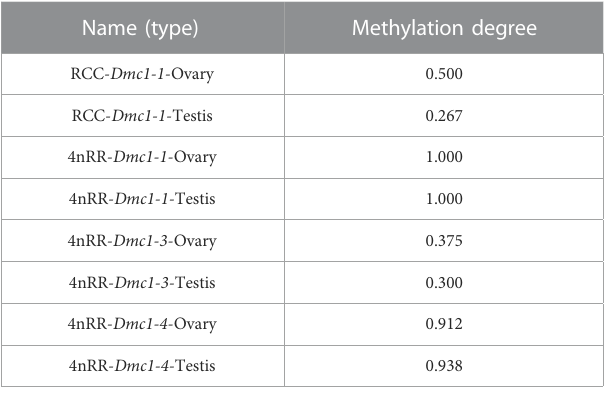
TABLE 2 Methylation degree of Dmc1 intron of RCC and